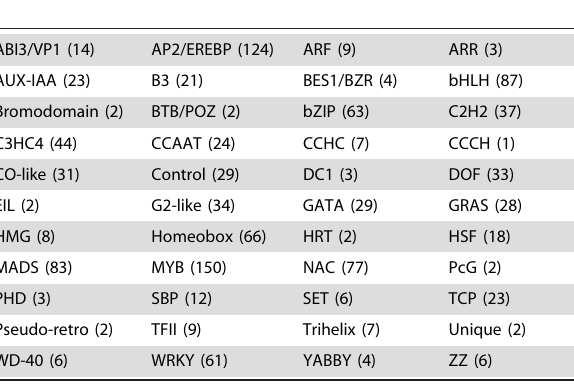
Table 2. Number of members in the TF families represented in the yeast